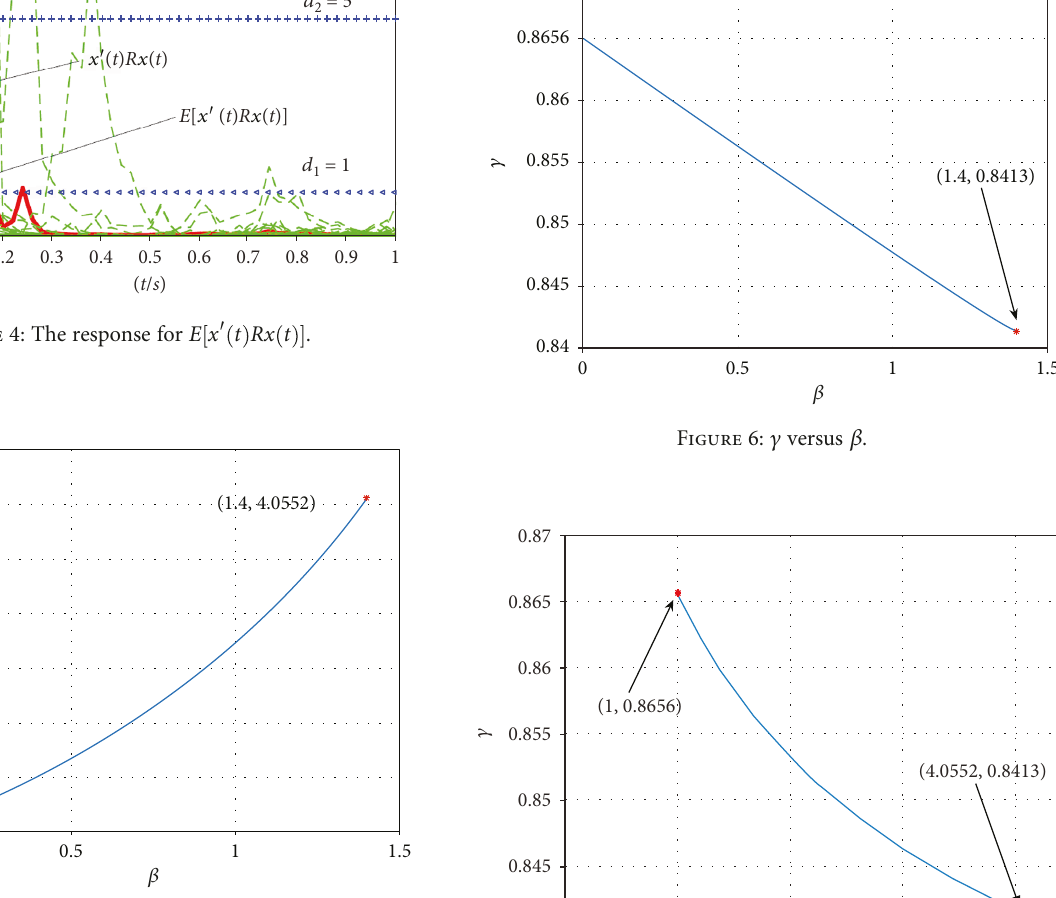
Figure 5: ξ versus β .